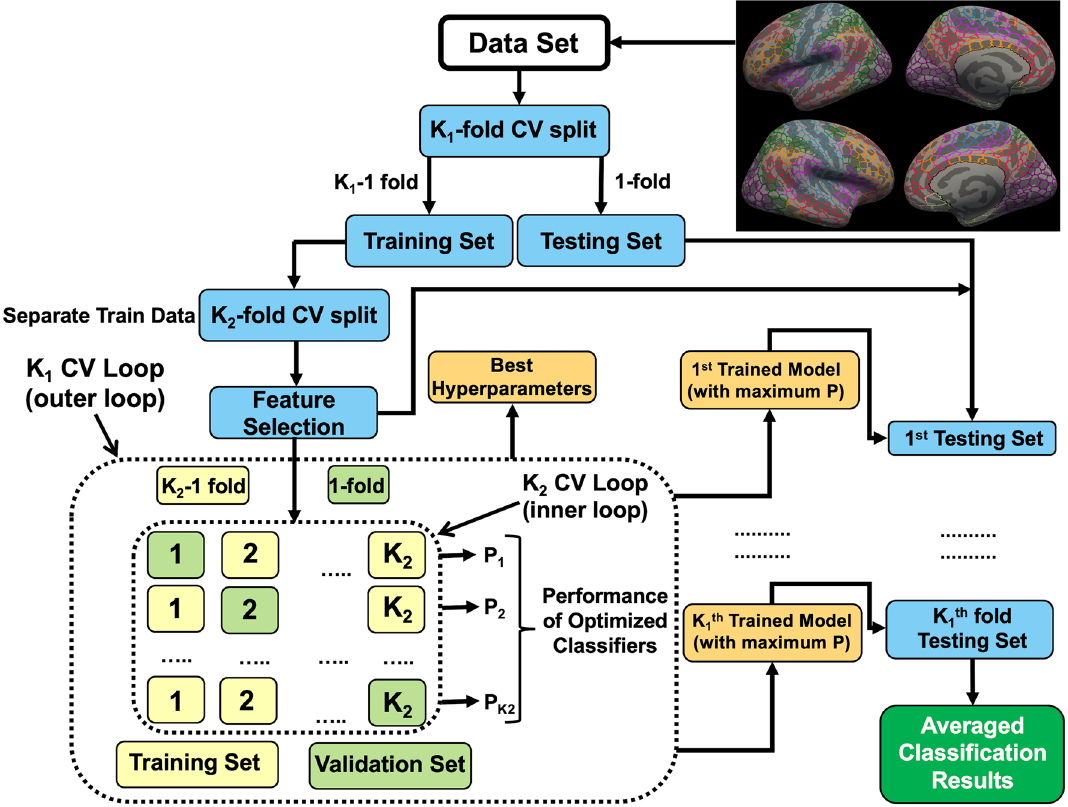
Fig. 2 Machine learning (ML) framework. Here, we describe an overview of the ML framework used in conjunction with feature identifica- tion, K × K nested cross-validation, and whole-brain morphometry data (i.e., cortical volume [CV]) to classify adolescents at suicide risk and 1 2 typically developing (TD)